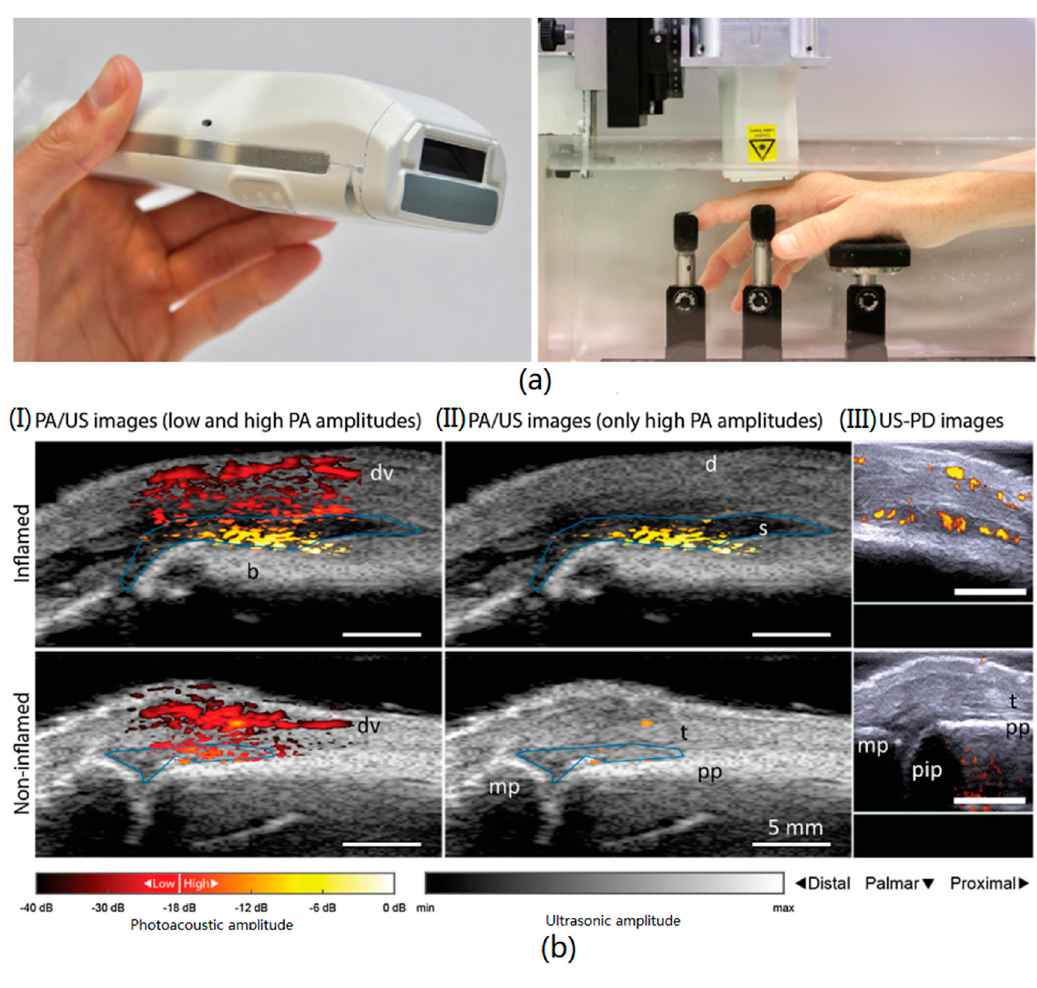
Figure 3. The imaging setup ( a ) and PA/US and US/PD images of an inflamed (upper row) and non-inflamed contra-lateral joint (bottom row) of an RA patient ( b ). PA/US images in (I) show a difference in color between inflamed and non-inflamed, corresponding to an increase in amplitude levels. When discarding low PA amplitudes in (II), only features in the inflamed joint are visible. Corresponding US-PD images are shown in (III). The blue line in the PA/US images indicates the ROI used for quantification of PA features in the synovial space. The 0 dB level is the maximum PA amplitude from the inflamed joint. d = dermis; dv = dorsal vein; pp = proximal phalanx; pip = proximal interphalangeal joint; mp = middle phalanx; s = synovium; t = extensor tendon. Reproduced with permission from Ref. [31].